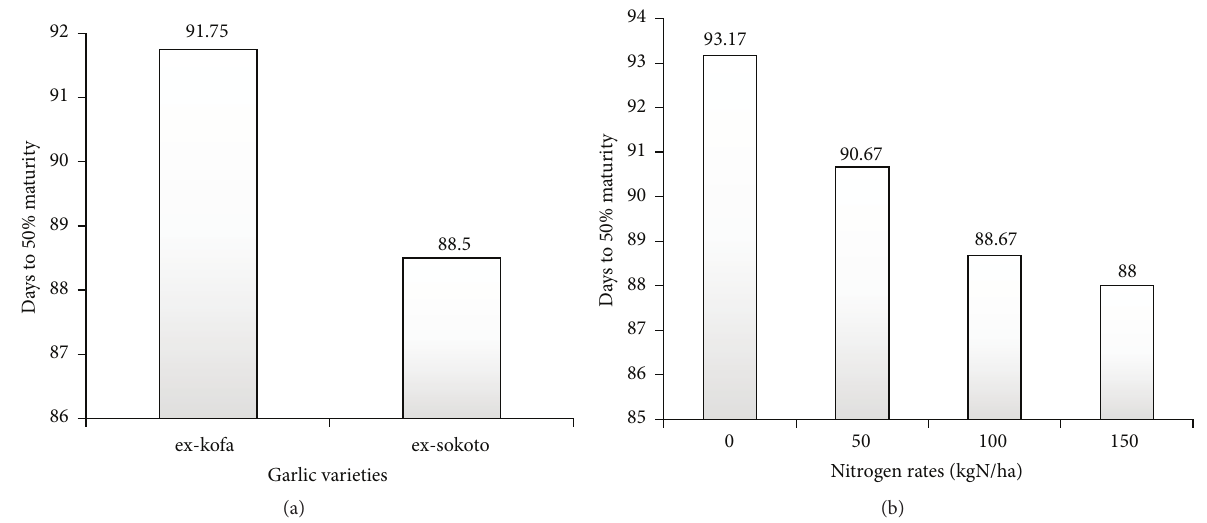
Figure 4: Significant differences ( 𝑝 < 0.05 ) between (a) variety, least significant difference (LSD) 3.23, and (b) different nitrogen rates, LSD 4.57, in the days to 50% maturity of garlic.